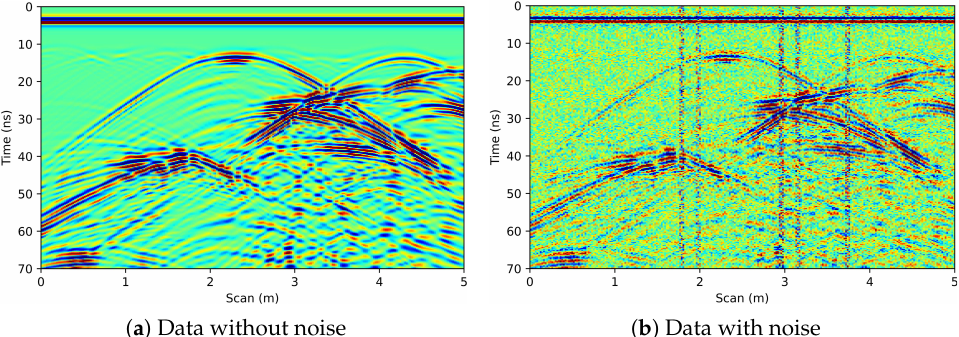
Figure 16. Synthetic profile data of a complex tunnel